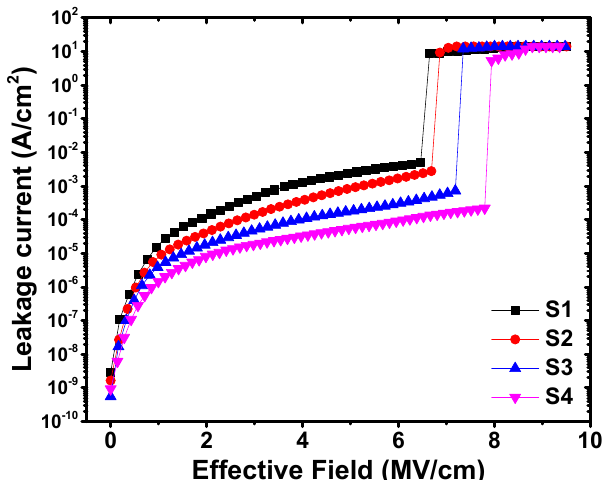
Figure 9. J–V characteristics of Al/HfO 2 /Ge and Al/HfO 2 /La 2 O 3 /Ge MIS capacitors.